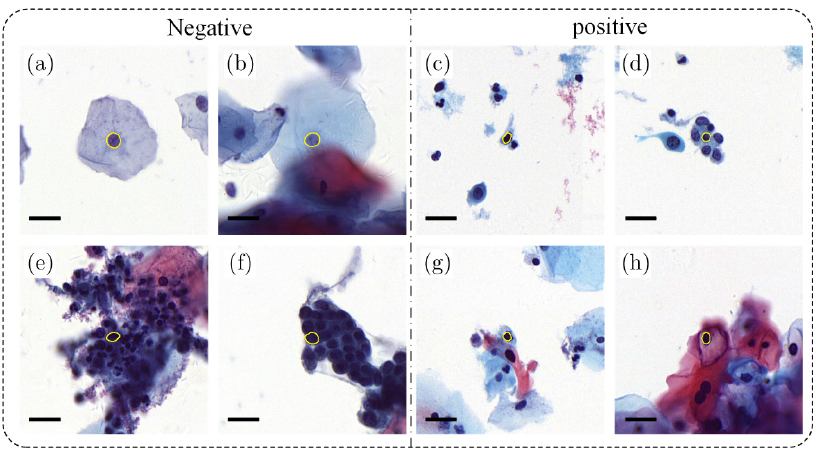
Fig. 4. Typical nuclei that are not recalled. (a) – (d) nuclei which are not recalled by classi¯er based on Ref. 10. (e) – (h) nuclei which are not recalled by classi¯er based on proposed method. (a), (b), (e) and (f) represent negative nuclei, (c), (d), (g) and (h) represent positive nuclei. Scale bar: 20 (cid:5) m.